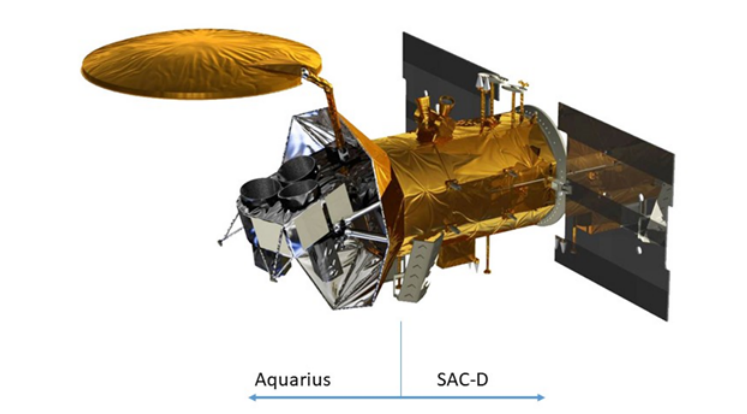
Figure 1. The Aquarius/SAC-D observatory. Aquarius is the feed-reflector assembly to the left. SAC-D is the observatory bus to the right, plus several